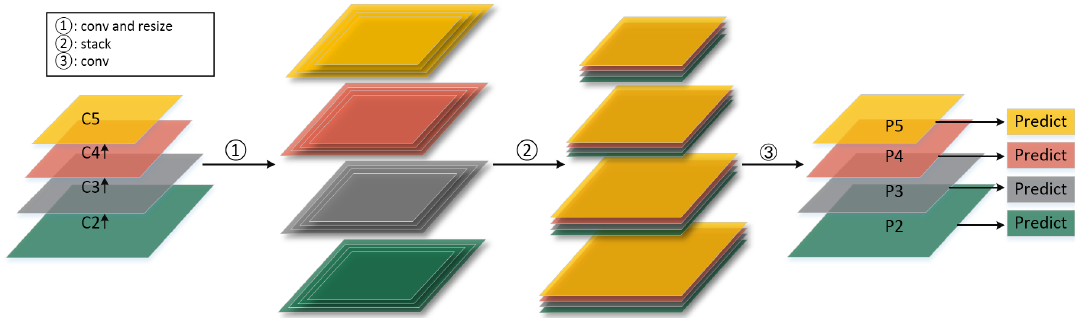
Figure 2. Feature fusion process in a Feature Fusion Pyramid Network.